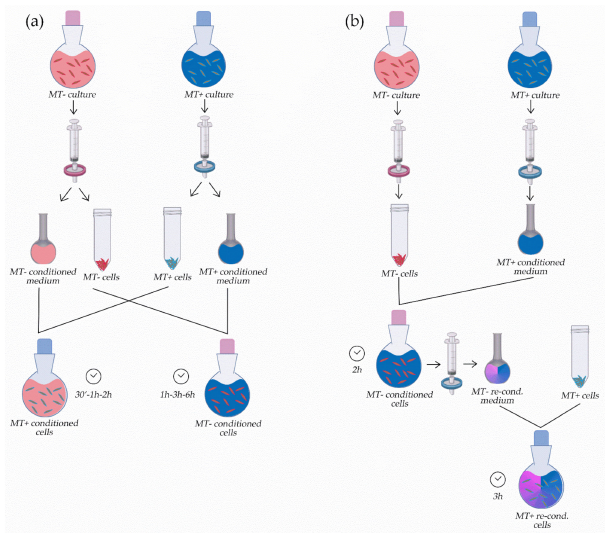
Figure 1. Diagram of the conditioning experiments. ( a ) Exponentially growing cultures are used to obtain the conditioned growth medium from the cells. The cell pellet of one mating type (MT) is incubated with the conditioned medium of the opposite one. The conditioned cells are then collected at different time points. ( b ) Diagram of the double conditioning experiment. In the first step MT − cells are incubated with the medium of an MT+ strain for 2 h; next, the same medium used to incubate MT − cells is filtered and used to incubate MT+ cells for a further 3